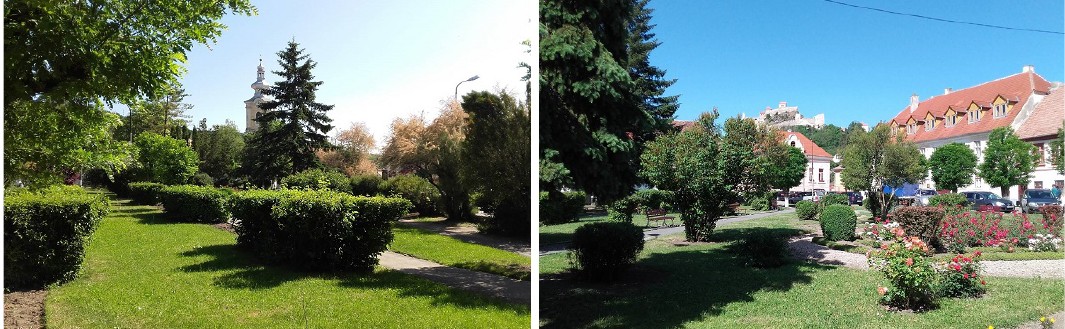
Figure 10: Rupea town’s Central Park (the former square) also known as the Danny Huwe Park Photographs by Zoltan MAROȘI,